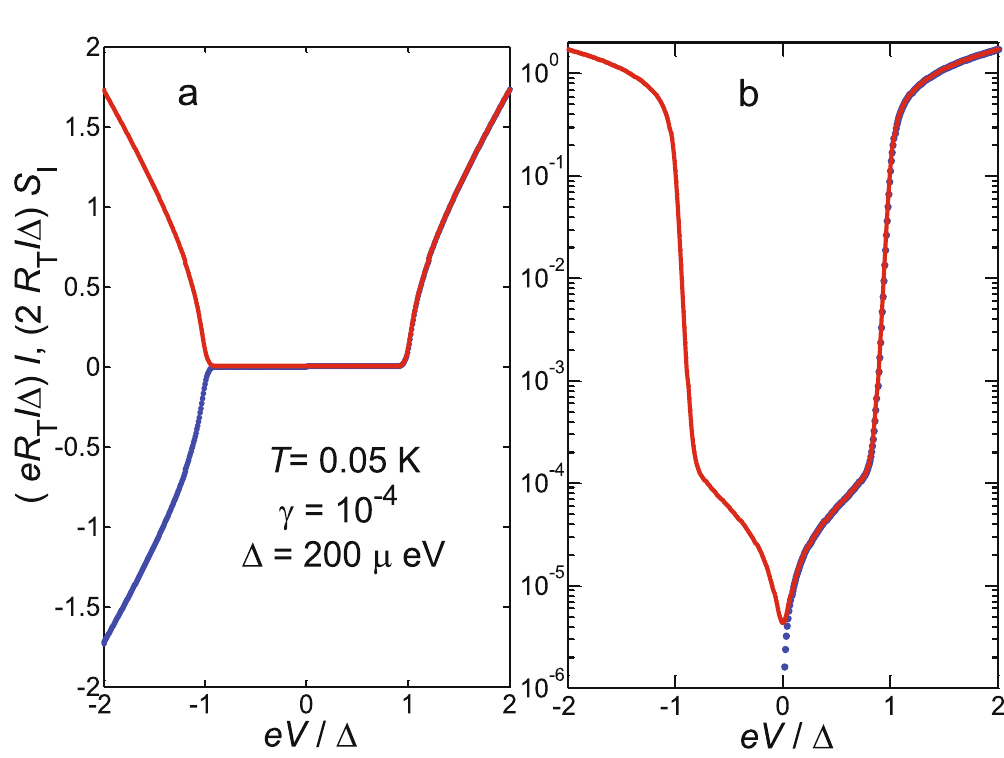
Figure 8. Current noise of a NIS junction. (a) Normalized IV characteristics of a NIS tunnel junction (blue dashed line) together with the current noise S (red solid lines) vs. bias voltage calculated at T = 0.05 K, with I shot the superconducting Al gap Δ = 200 μ e V. Here, the dimensionless parameter γ is the ratio between NIS junction asymptotic resistance at high bias voltage and the sub-gap resistance, used in the modeling of a smeared BCS density of states . (b) I and S as in (a) but I shot plotted on a semilogarithmic scale.